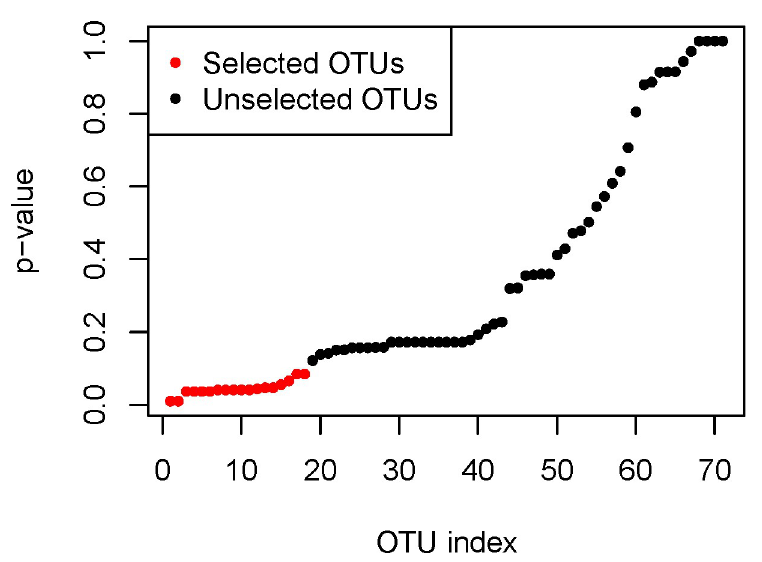
Fig 3. Microbiome: Principal Coordinates Analysis (PCoA). Non-metric dimensional analysis of 16S microbial features in peritoneal fluid from patients with adnexal masses shows distinctive clustering of sample points from patients diagnosed with OC (red dots, n = 10/30) compared to those with benign masses (blue dots, n =